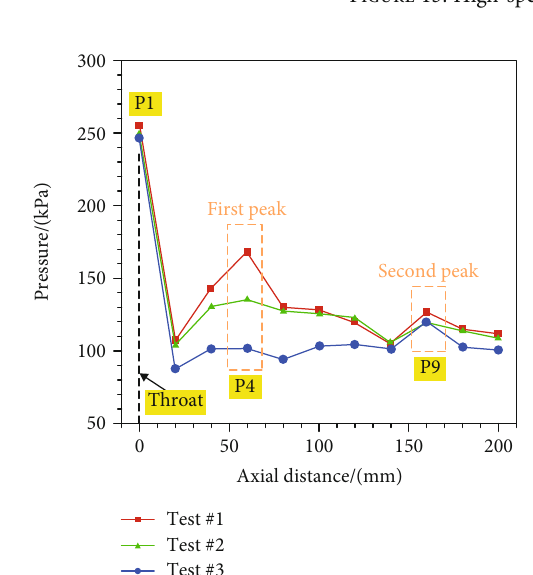
Figure 13: High-speed photography images of Test #3.